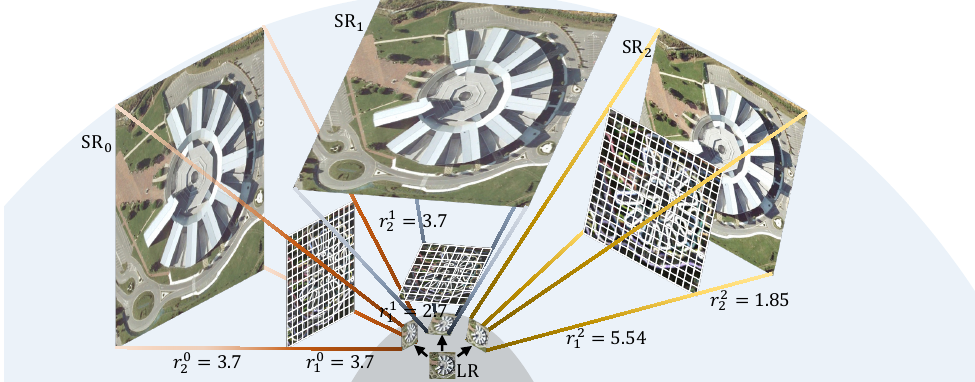
Figure 5. The proposed scale cumulative ascent (SCA) method operates at a scale factor of 9.7. The figure depicts that LR in the low-resolution manifold space is enlarged through three pathways, resulting in SR 0 , SR 1 , and SR 2 in the high-resolution manifold space. Here, r j factor of the j -th pathway. The final prediction is obtained by averaging these SR images. On the one hand, SCA improves the effectiveness of dense prediction and increases accuracy in out-of- distribution scenarios by augmenting the density of the latent code. On the other hand, as a single LR image may correspond to multiple HR images, utilizing SCA to average multiple predictions enhances the robustness of the generated HR